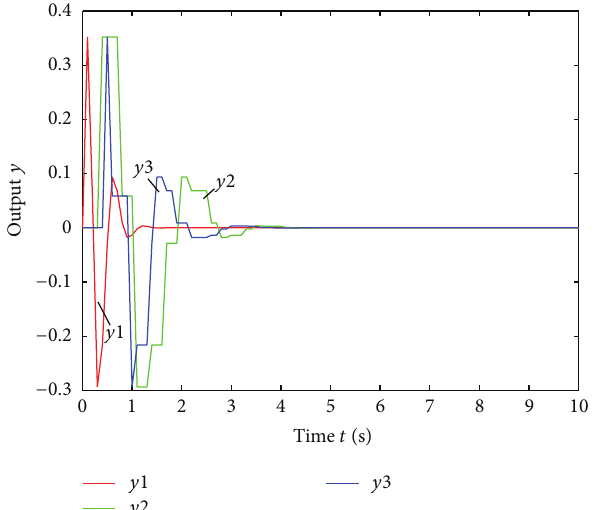
Figure 3: Outputs of the wireless networked system in different